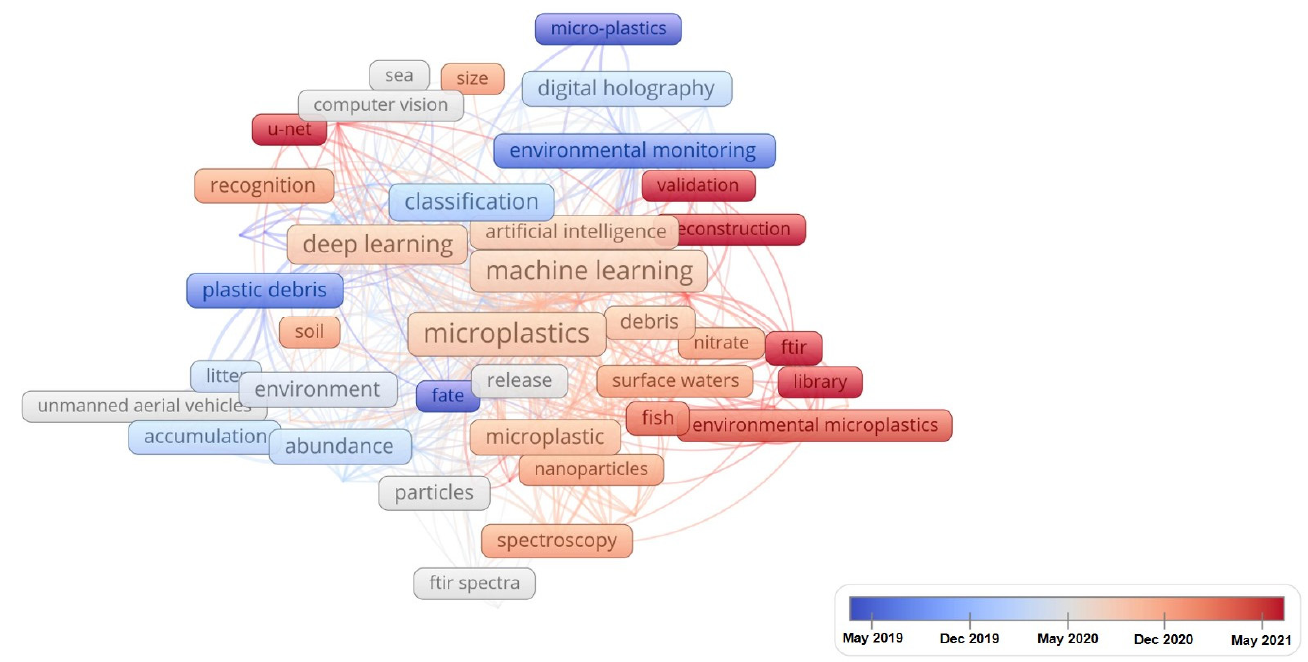
Figure 24. Keywords temporal evolution (visualized with VOSviewer).